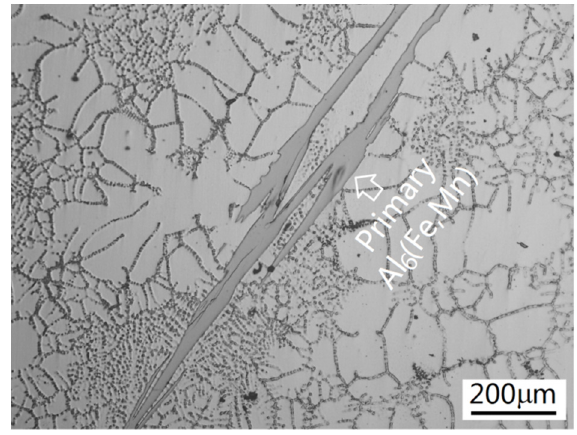
Figure 9. The microstructures of Alloy I ‐ 5 after interrupted quenching at 650 °C.